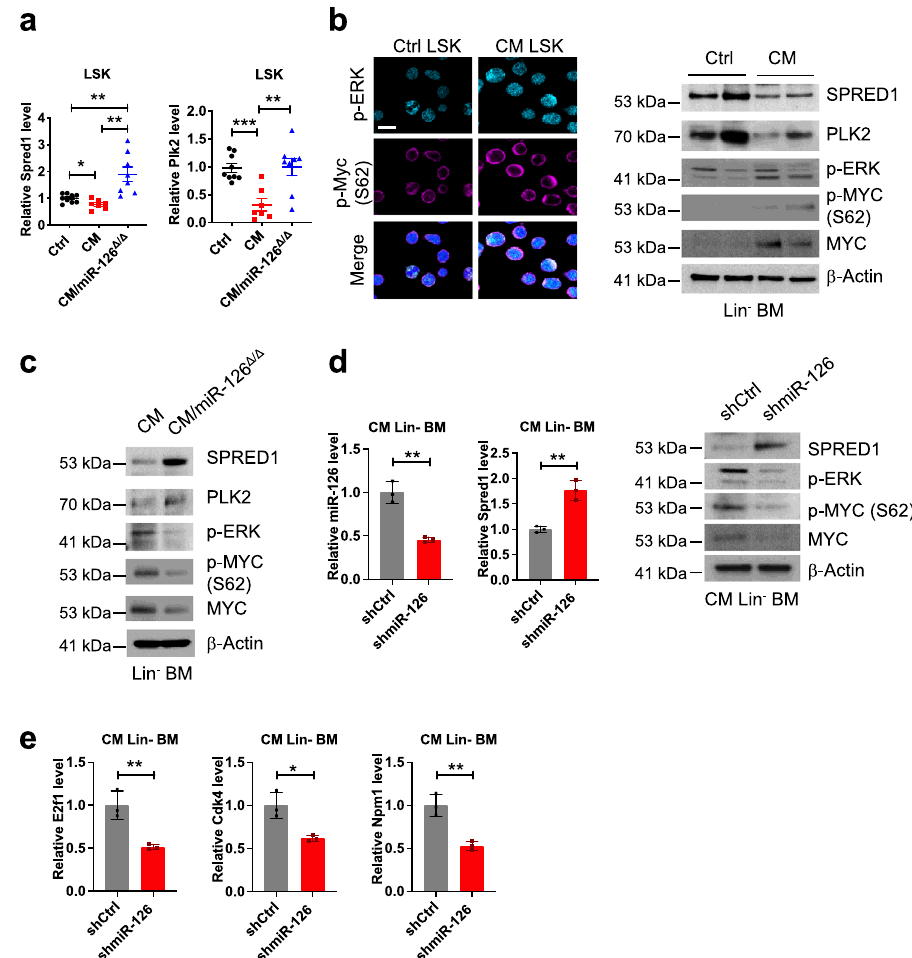
Fig. 4 Expression of miR-126 enhances MYC activity through downregulating SPRED1 , PLK2 , and activating the ERK-MYC axis in CM-AML. a Relative expression levels Spred1 ( CM vs. Ctrl p = 0.015; CM/miR-126 Δ / Δ vs. Ctrl p = 0.0022; CM vs. CM/miR-126 Δ / Δ p = 0.0035) and Plk2 ( CM vs. Ctrl p = 0.0002; CM vs. CM/miR-126 Δ / Δ p = 0.0042) normalized to level of B2m in Ctrl (black), CM (red) and CM/miR-126 Δ / Δ (blue) preleukemic LSK. b Representative immunostaining of p-MYC (S62; magenta) and p-ERK (cyan) in control and CM AML LSK (left; scale bar 10 μ m); western blot of SPRED1, PLK2, p-ERK, p-MYC (S62), and MYC in control and CM AML lineage-negative (Lin − ) BM cells (right). c Western blot of SPRED1, PLK2, p-ERK, p-MYC (S62) and MYC in CM vs. CM/miR-126 Δ / Δ Lin - BM cells. d Relative expression in CM-AML cells expressing shCtrl (black) vs. shmiR-126 (red) for miR-126 ( p = 0.0018) and Spred1 ( p = 0.0028) normalized to snoRNA234 and B2m , respectively (left); western blot of SPRED1, p-ERK, p-MYC (S62), and MYC (right) 2 days after transduction with shCtrl or shmiR-126 (right). e Relative expression levels of E2f1 ( p = 0.0072), Cdk4 ( p = 0.0136), Npm1 ( p = 0.0041) normalized to level of B2m in shCtrl (black) or shmiR-126 (red) expressing CM-AML cells. Each dot represents data from an individual mouse and presented as the mean ± SEM in a ; data in d , e are presented as the mean ± SD and statistical signi fi cance for all comparisons shown was determined using two-tailed T tests (* p < 0.05; ** p < 0.01; *** p < 0.001); representative results of two independent experiments with similar results are shown in b , c